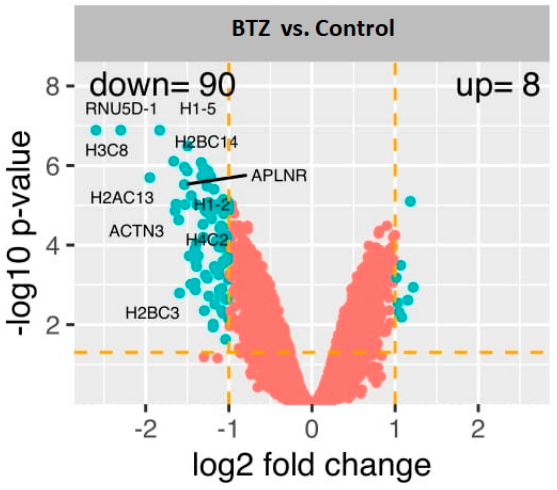
Figure 1. The volcano plot of global gene expression. Genes are represented by dots ( p < 0.05, fold change > 2). The diagram also shows the symbol for the genes with the greatest expression change.